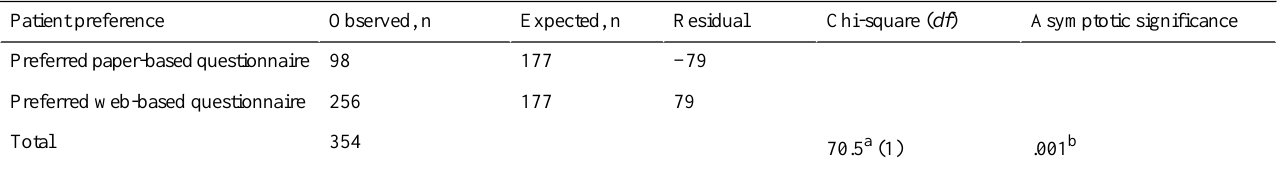
Table 6. Analysis of participant